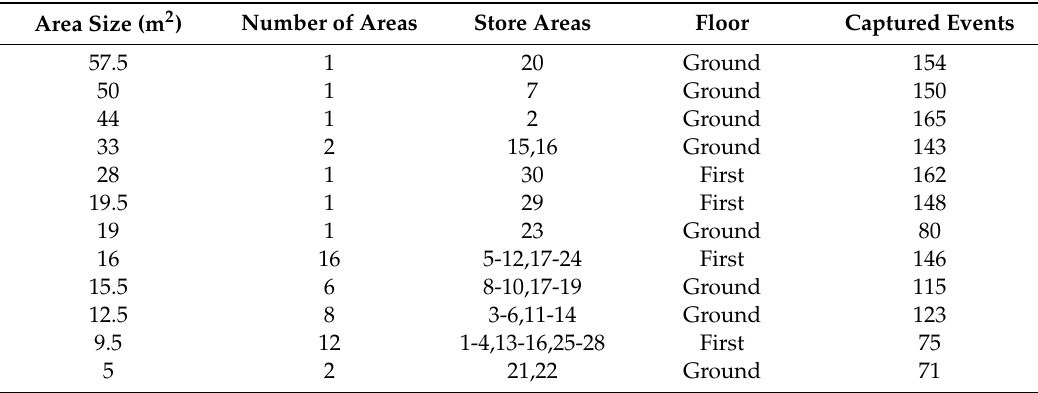
Table 5. Fingerprinting data